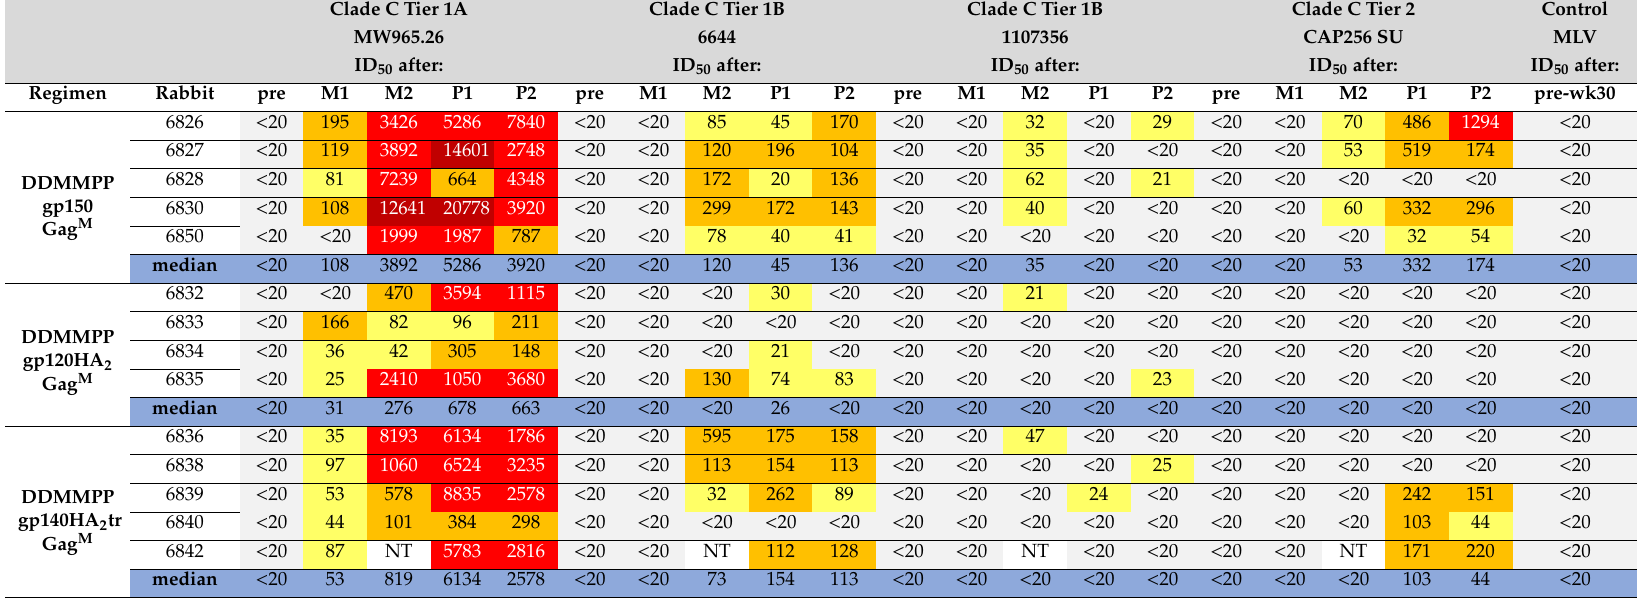
Table 2. Neutralizing antibody titers elicited in